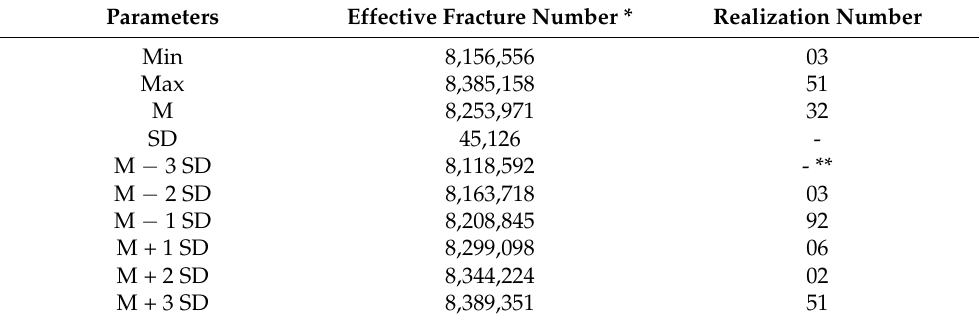
Table 6. Statistical summary of the effective fracture numbers for the 49 DFN realizations.